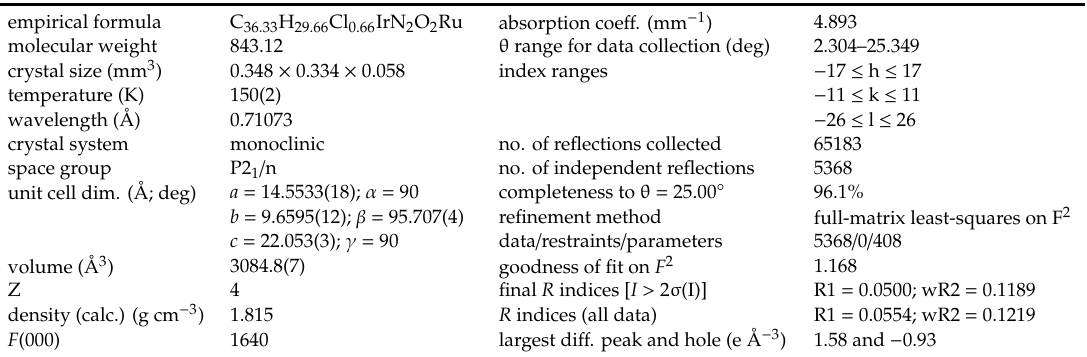
Table 1. Crystal Data and Structural Refinement for 3